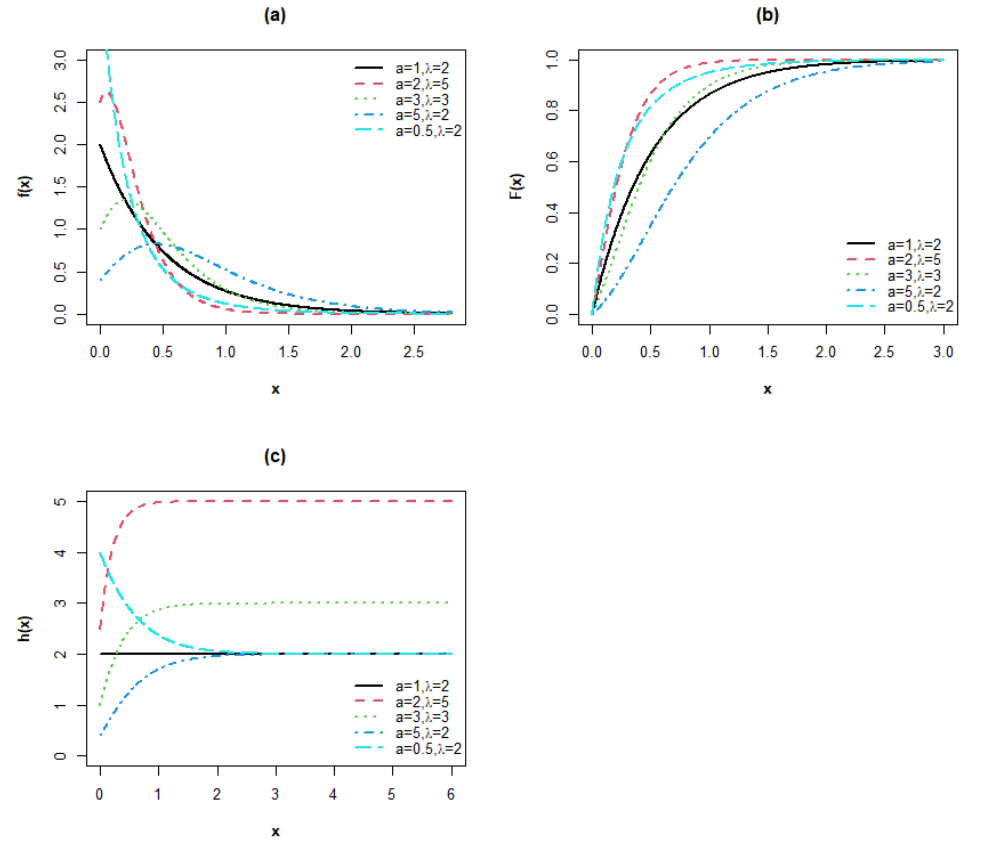
Figure 2. Plots of the ( a ) pdf, ( b ) cdf and ( c ) hrf for the MPoE